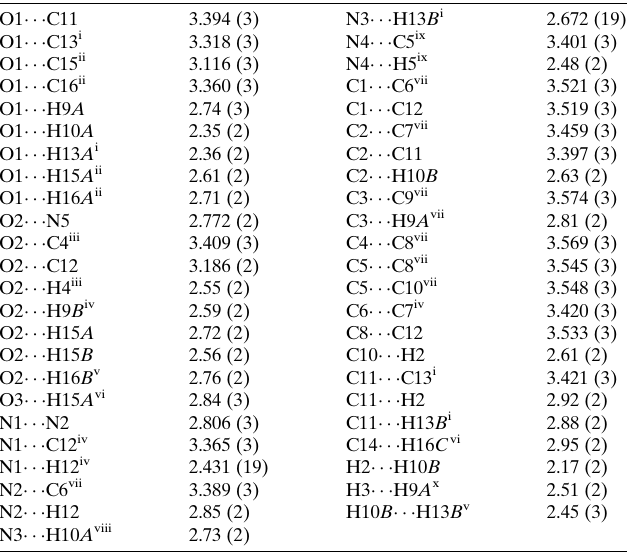
Table 2 Selected interatomic distances (A˚ ).